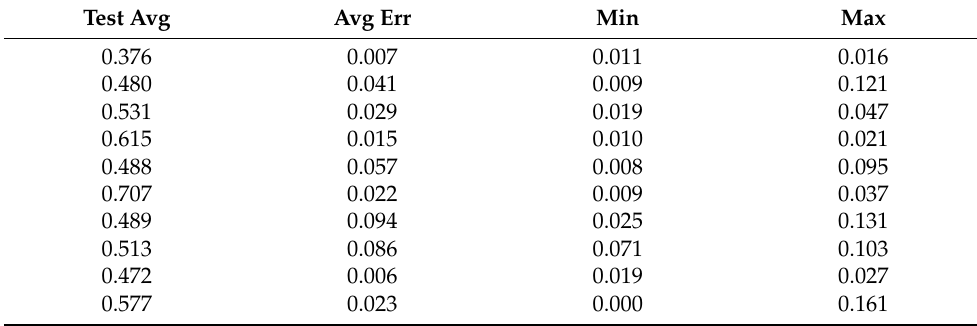
Table A191. Set 3, trials 21–30 data (actual PR value).